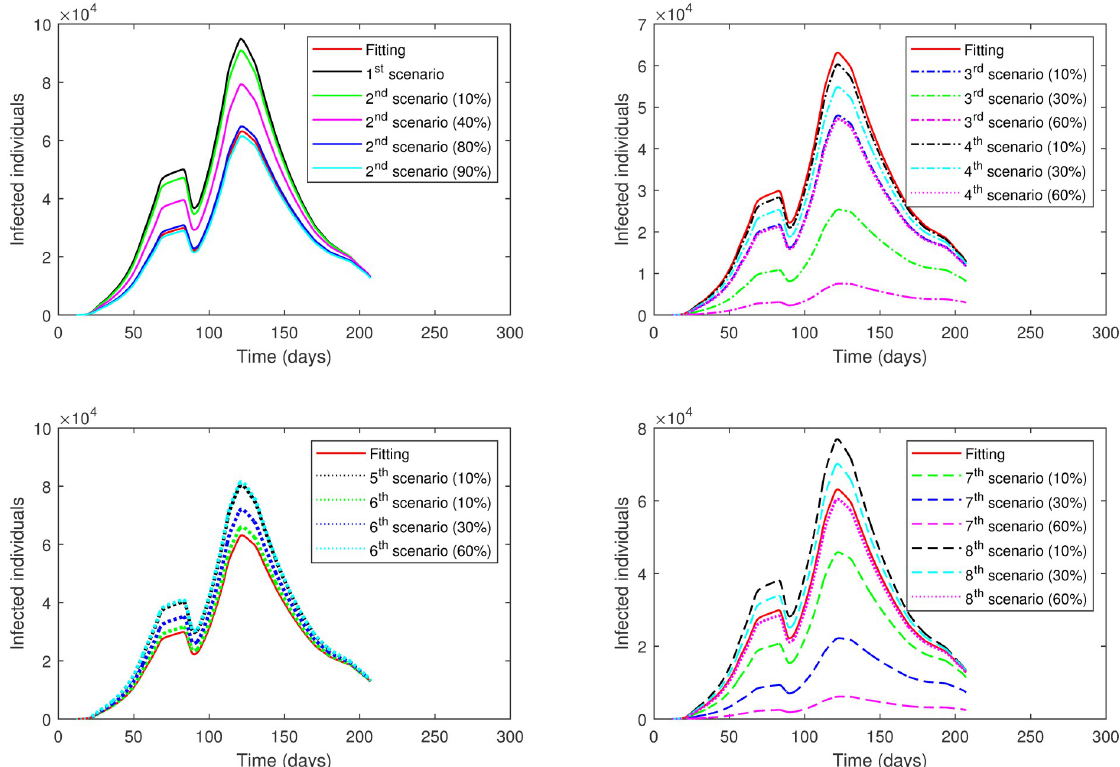
Fig 7. The numerical solution of model (1) for infected compartment vs. time with different scenarios of Phase 1 in the First Case: 1 st scenario, no lockdown is implemented; 2 nd scenario, no lockdown while SD increases; 3 rd scenario, lockdown increases; 4 th scenario, SD increases; 5 th scenario, lockdown decreases; 6 th scenario, SD decreases; 7 th scenario, lockdown and SD increases; 8 th scenario, lockdown decreases and SD